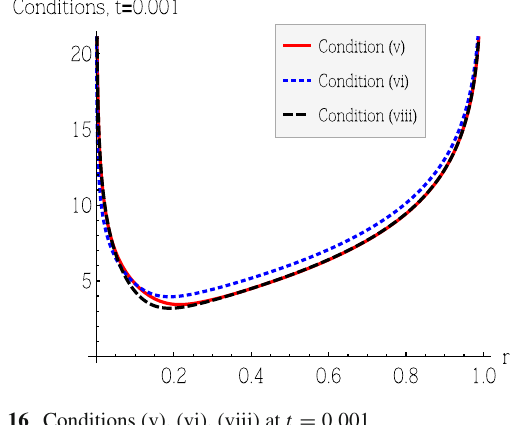
conditions (i), (ii) and (iv) and in Figs. 16, 17 and